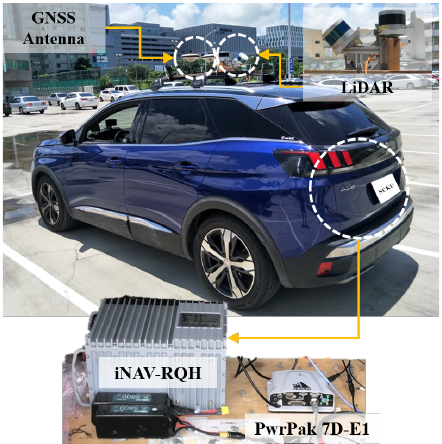
Figure 3 . Experimental platform with navigation sensor